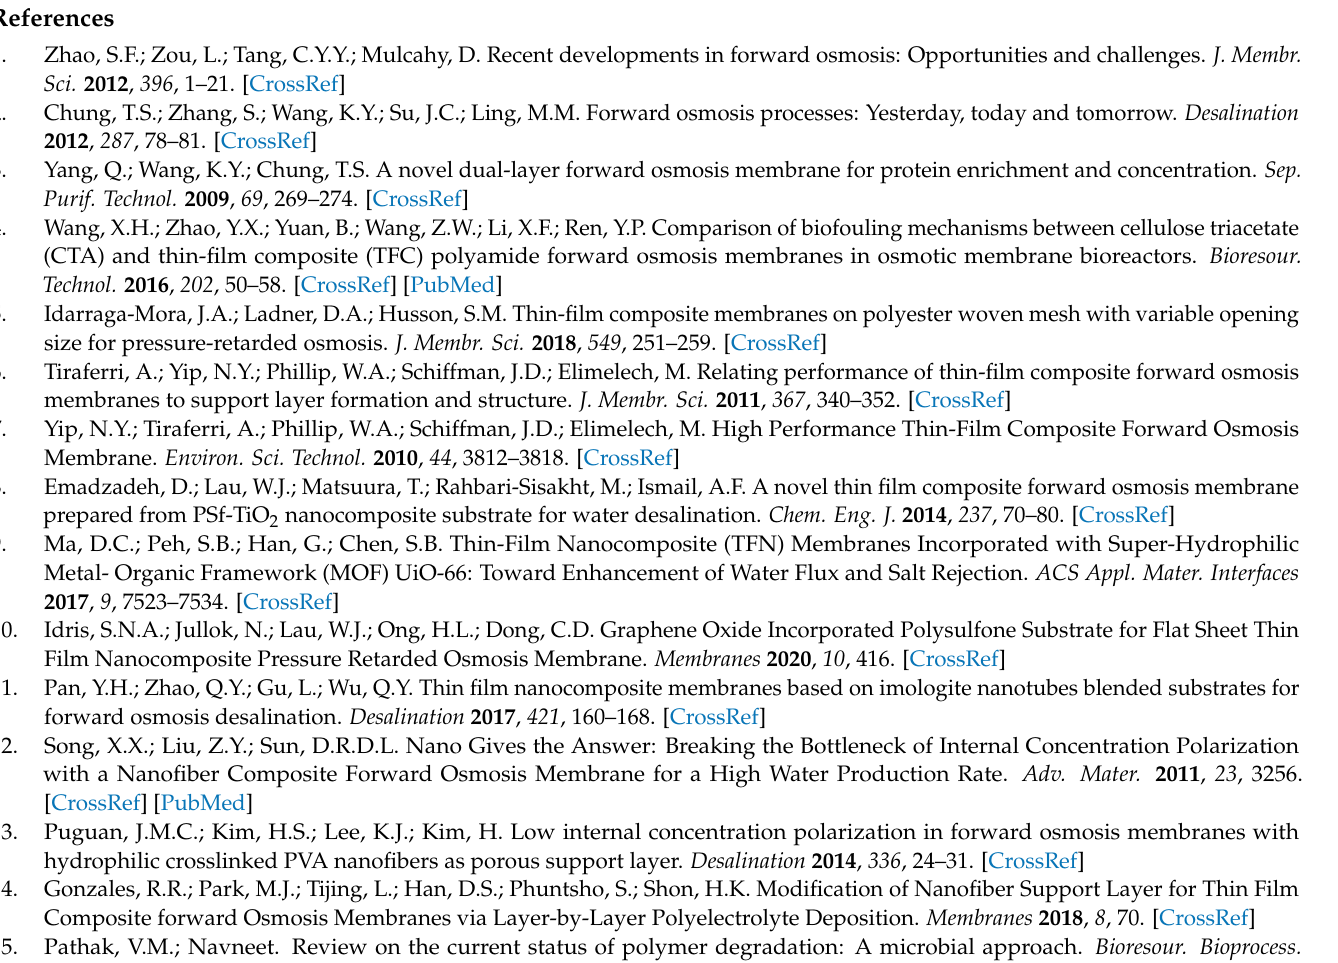
ESC-GO membranes at polyamide layer, Figure S2: Defects at polyamide layer in ESC membranes, Figure S3: Large agglomeration of GO in ESM-GO